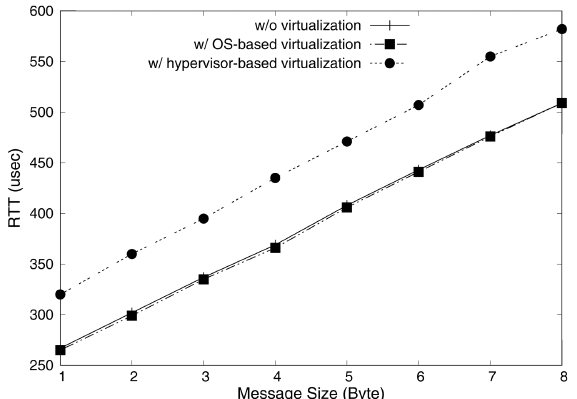
Figure 7. Average Round-Trip-Time (RTT) of different message sizes.